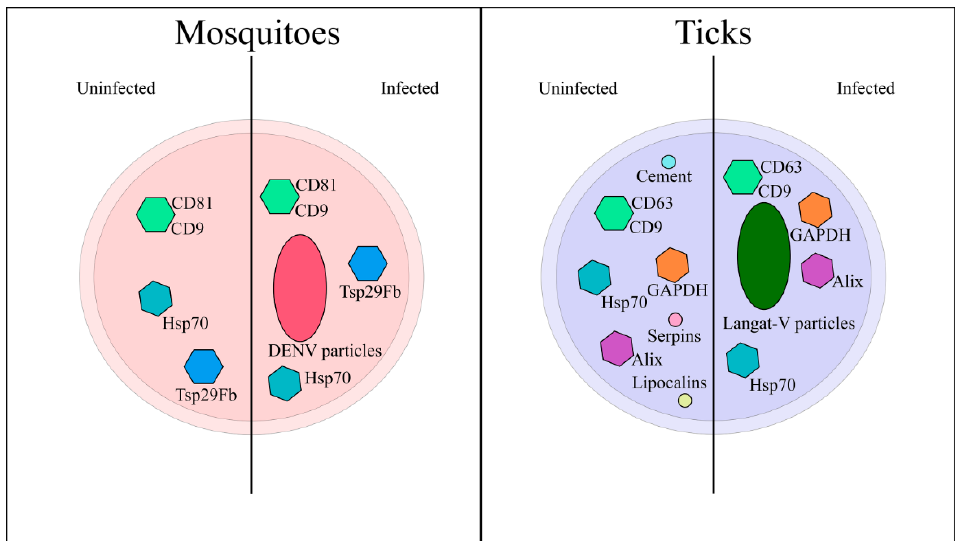
Figure 2. Extracellular vesicle cargo found within mosquito- and tick-derived vesicles. Mosquito- derived vesicles contain several well-known extracellular vesicle markers, such as tetraspanins (CD81 and CD9) as well as Heat Shock Protein 70 (Hsp70). These proteins are present within vesicles derived from infected and uninfected cells. EVs secreted by DENV-infected cells contain viral particles that can start an infection in naïve cells. Tick vesicles, on the other hand, contain EV markers (CD9, CD63, Alix, and Hsp79), metabolic proteins (GAPDH), and tick salivary effectors (Lipocalins, Cement, and Serpins). Whether these salivary effectors are affected by bacterial or viral infection is unknown. EV markers and viral particles are found within EVs secreted by virus-infected tick cells. In both systems, arthropod-derived vesicles appear to facilitate viral spread and pathogen